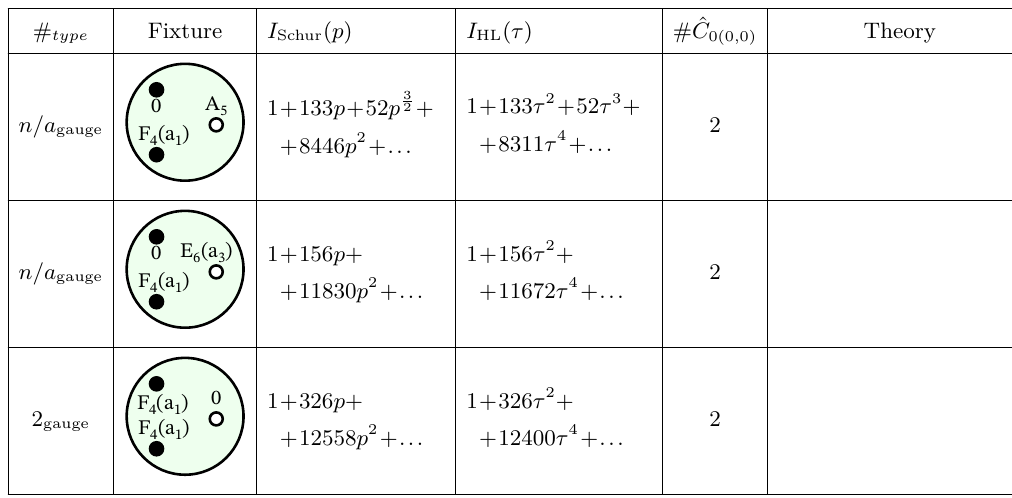
Table 3. Product theories corresponding to fixtures in the twisted E 6